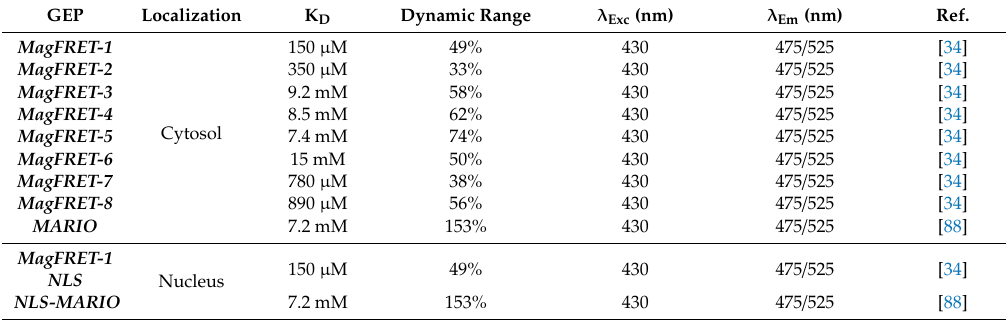
Table 2. Selection of FRET-based GEPs suitable for subcellular Mg 2 +